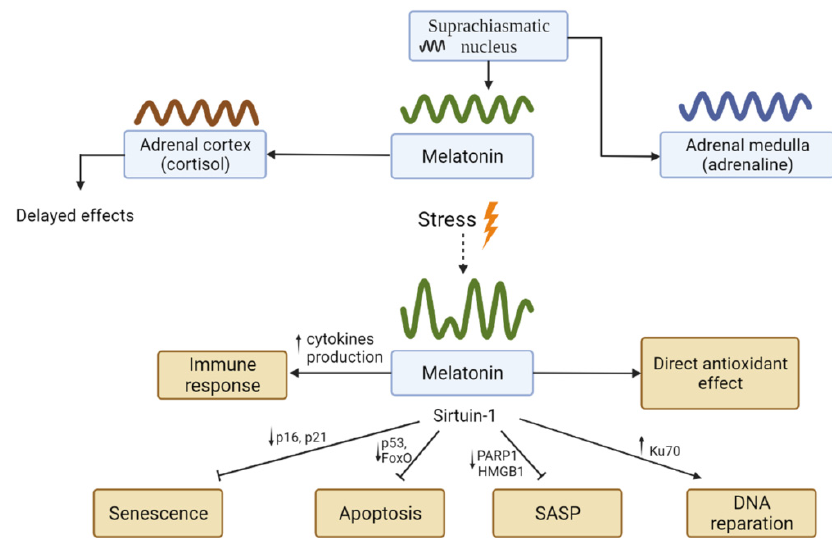
Figure 8. Schematic representation of effects of melatonin on intracellular processes and signalling pathways related to senescence, apoptosis, and cell cycle regulation. ↑ —stimulation, ↓ —inhibition.